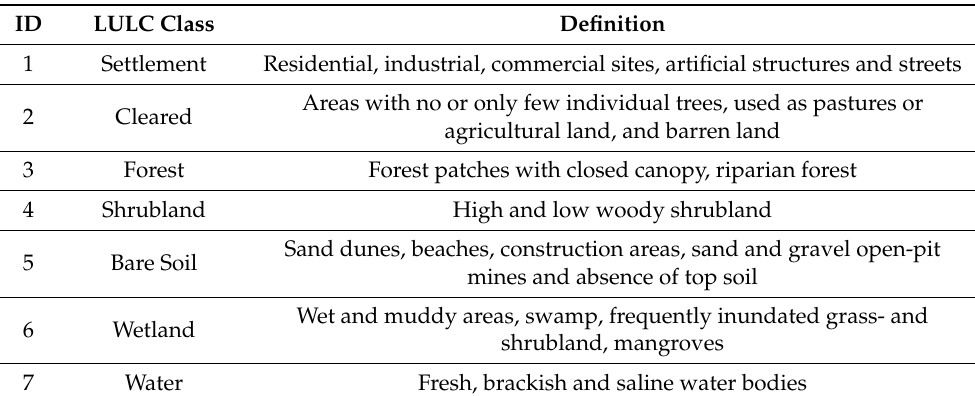
Table 2. Land use and land cover classes and their